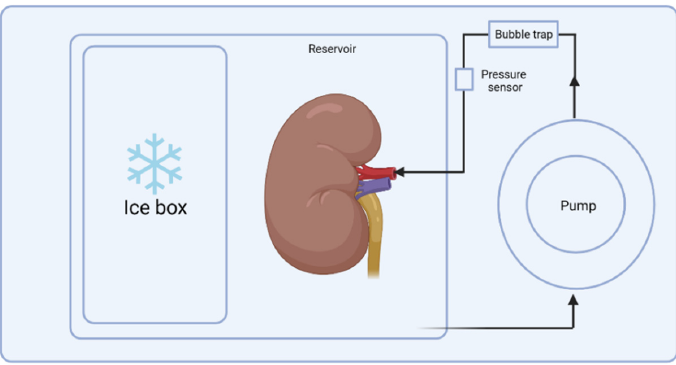
Figure 2. The scheme of hypothermic machine perfusion of a kidney.